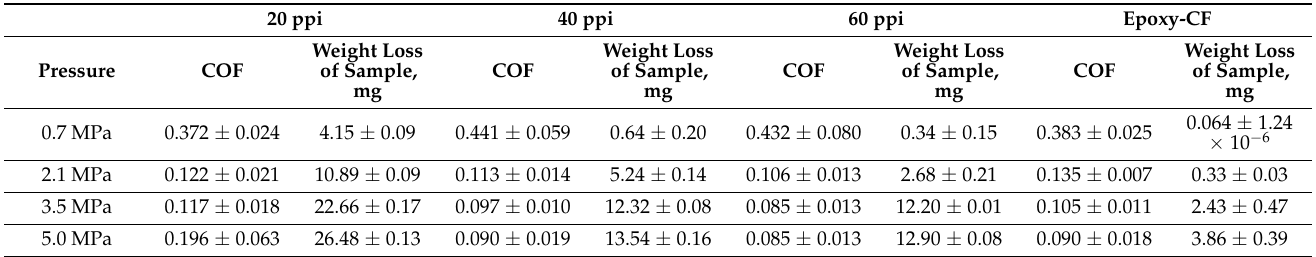
Figure 6. Coefficient of friction vs. sliding distance mean curves determined for neat epoxy and composites with carbon foams and carbon micro-fillers: ( a ) under 0.7 MPa load, ( b ) under 2.1 MPa load, ( c ) under 3.5 MPa load and ( d ) under 5.0 MPa load. Table 2. Coefficient of friction and weight loss of sample determined for epoxy—C of and epoxy—CF composites under different pin loads.